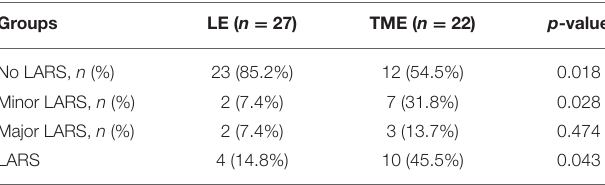
TABLE 3 | Low anterior resection syndrome (LARS) comparison between the two groups.